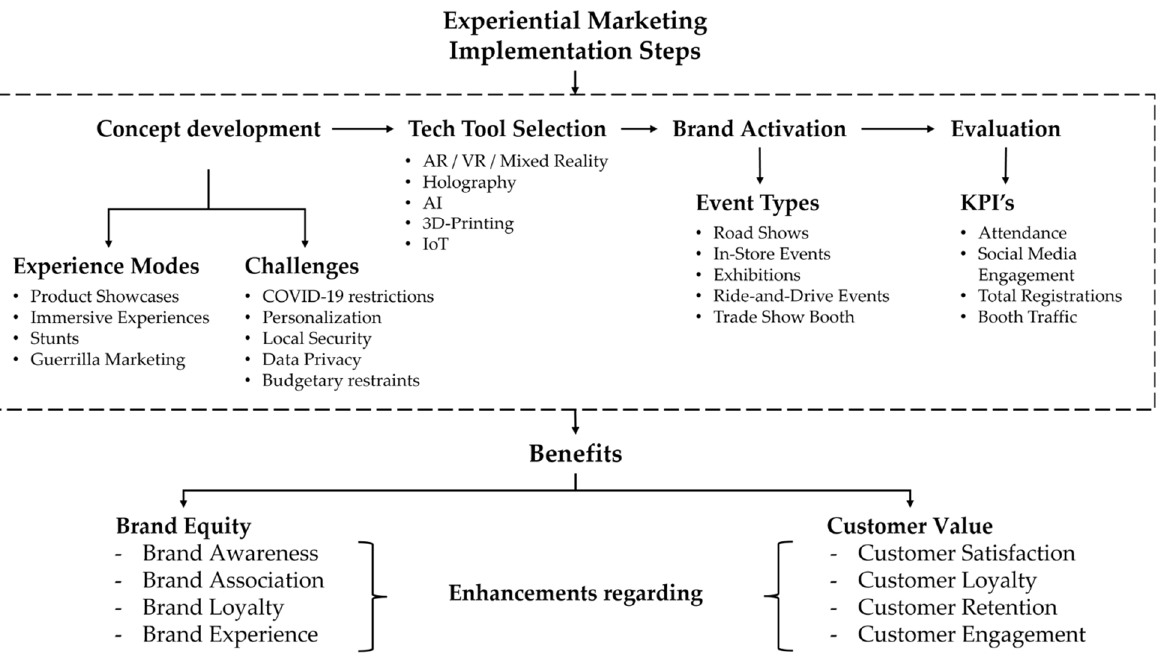
Figure 1. A comprehensive view of experiential marketing implementation